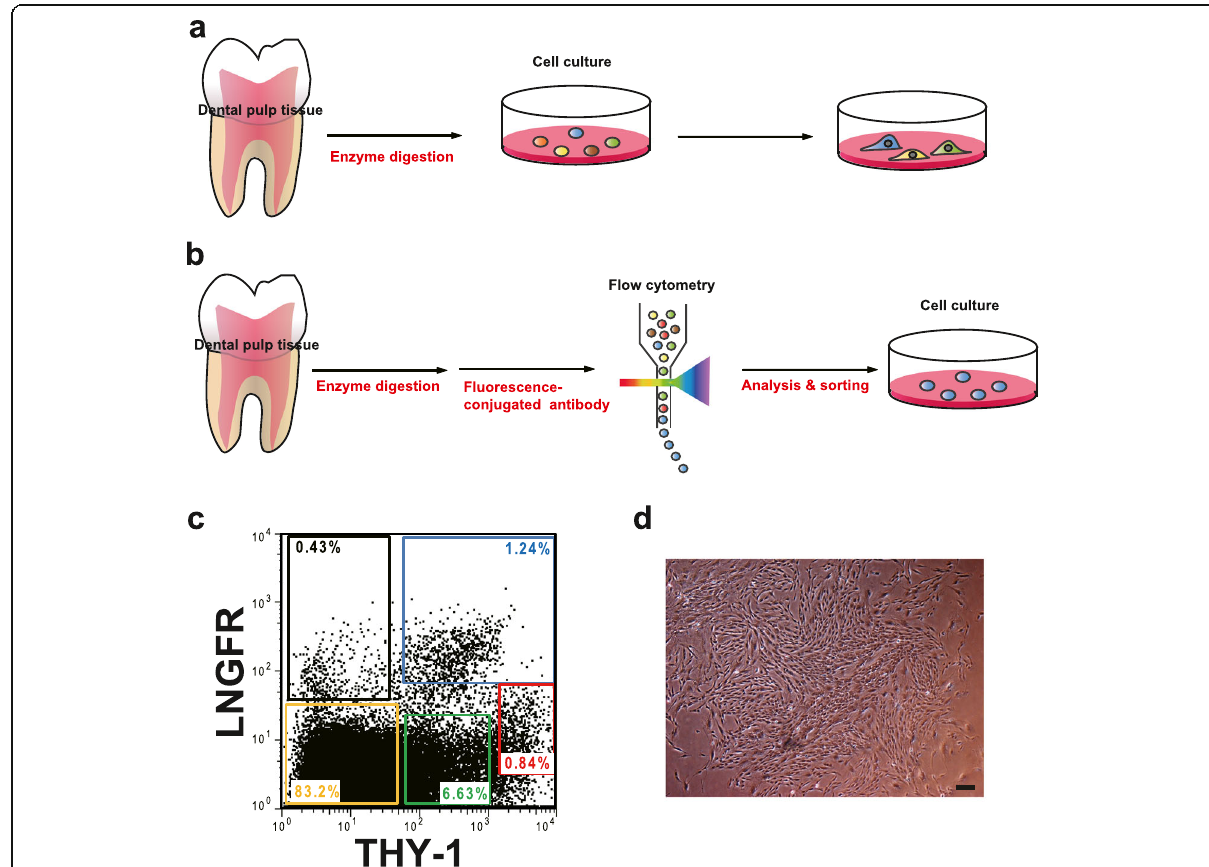
Fig. 1 a Traditional isolation of dental pulp stem/progenitor cells (DPSCs) by adherent culture on dishes. b Prospective isolation of DPSCs by flow cytometric identification of cell surface markers. c Representative fluorescence-activated cell sorting profiles of dental pulp cells. d A representative phase-contrast micrograph of plastic-adherent colony-forming LNGFR Low+ THY-1 High+ cells with fibroblast morphologies. Scale bars = 100 μ